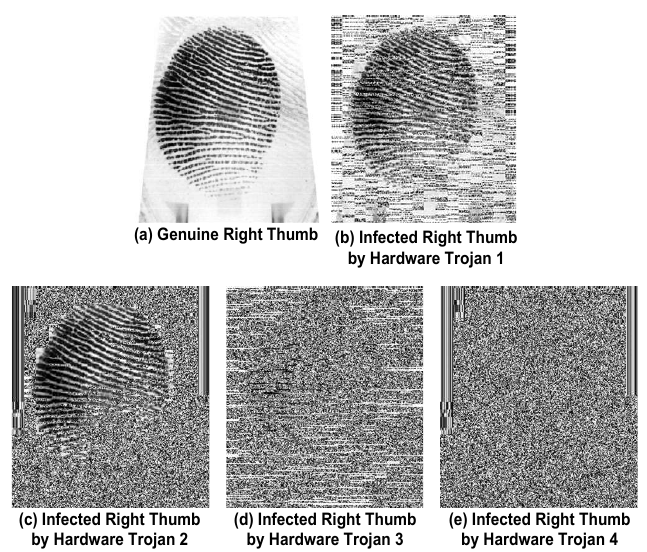
Figure 7. Attack Fingerprint Example (2): The payloads of the Hardware Trojans in sabotaging the image prints of the right